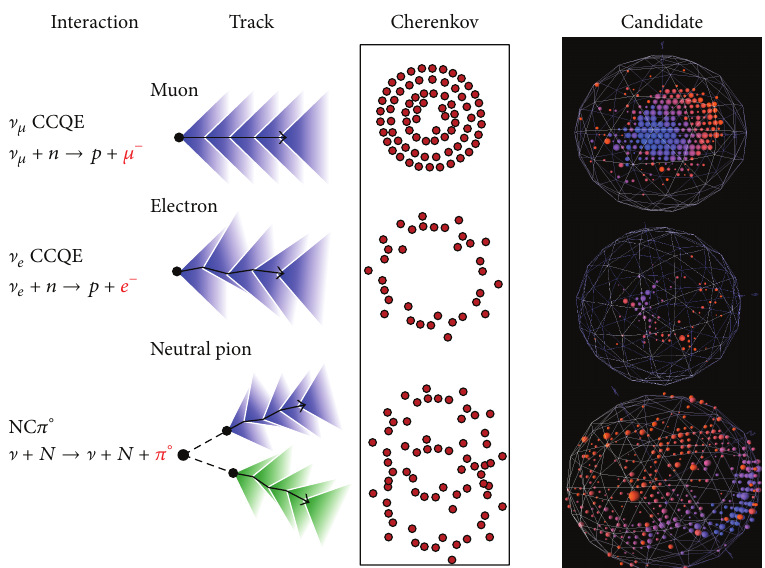
Figure 2: (Color online) MiniBooNE particle reconstruction [4]. From top to bottom, a muon neutrino charged-current quasielastic (CCQE) interaction, an electron neutrino CCQE interaction, and a neutral current, neutral pion production (NC1 𝜋 ∘ ) interaction. The second and the third columns show the characteristics of tracks and Cherenkov rings [7], and the last column shows the event displays of candidate